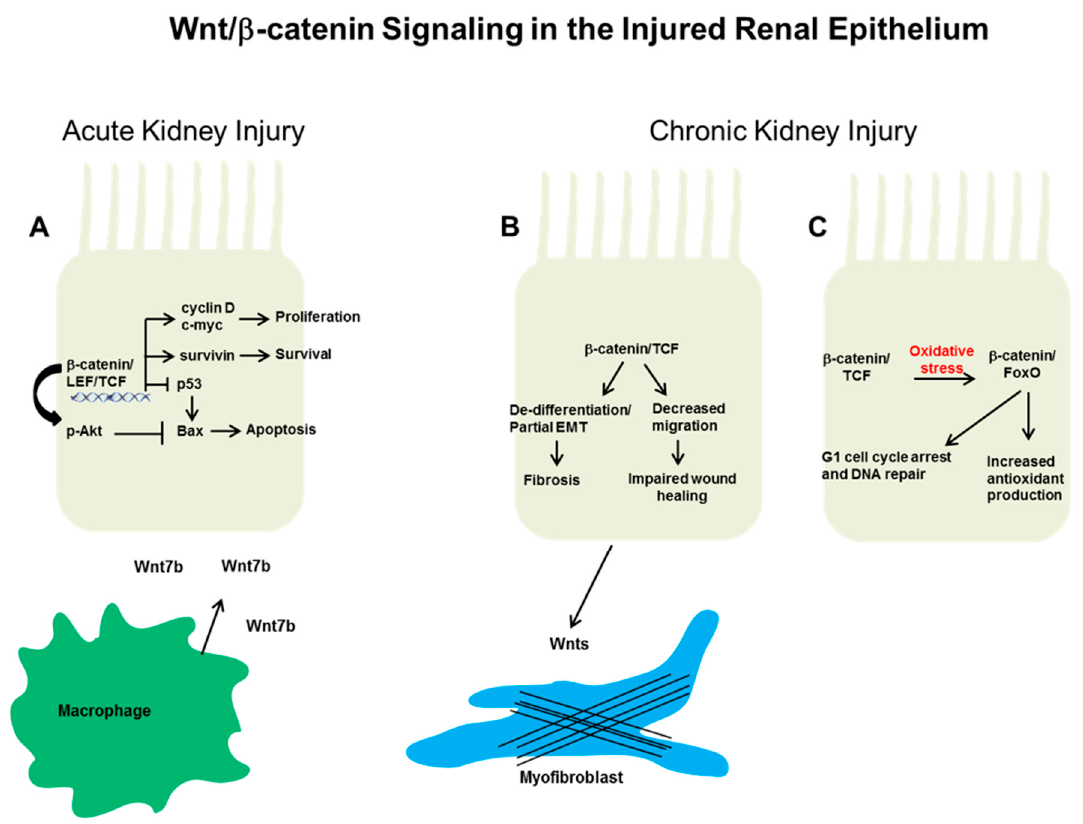
Figure 1. Putative mechanisms whereby epithelial Wnt/ β -catenin signaling affects the response to injury. ( A ) After acute kidney injury (Aki) in rodent models, β -catenin signaling can protect against epithelial apoptosis and promote proliferative repair. These actions are thought through β -catenin-dependent transcriptional upregulation of cyclin D, c-Myc, and survivin. In addition, β -catenin suppresses the pro-apoptotic protein Bax (Bcl-2 associated X protein) through blocking p53 and/or by augmenting protein kinase B (Akt) phosphorylation. Macrophage-derived Wnt7b promotes cell cycle progression in injured epithelial cells through paracrine signaling. In chronic kidney injury, the effect of epithelial Wnt/ β -catenin signaling on repair or fibrosis is not as clear. ( B ) β -catenin signaling may be detrimental by promoting epithelial de-differentiation or decreased migration, which can lead to increased tubulointerstitial fibrosis and impaired wound healing, respectively. In addition, epithelial-derived Wnts may activate surrounding fibroblasts/pericytes to become myofibroblasts, the main producers of extracellular matrix. Alternatively, ( C ) the high oxidative stress environment of chronic kidney disease (CKD) induces a switch in β -catenin transcriptional binding partners from lymphoid enhancer factor/T cell factor (Lef/Tcf) to forkhead box protein O (FoxO). β -catenin/FoxO have been shown to mediate increased antioxidant production and cell cycle arrest/DNA repair, potentially beneficial responses in other systems but have not been studied in the CKD kidney.